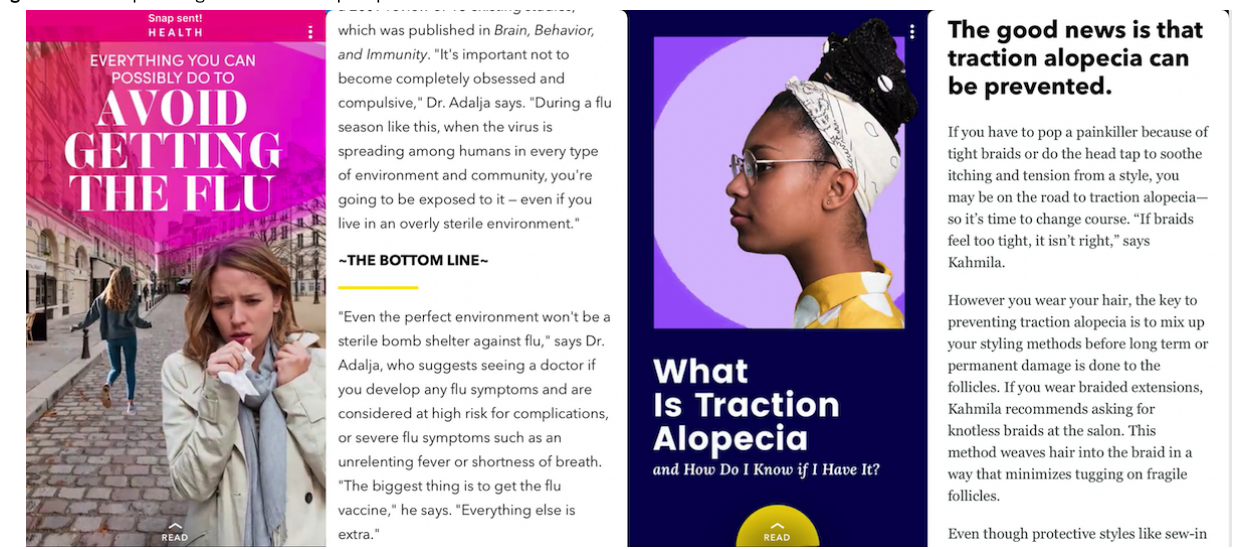
Figure 2. Examples of general health topics posted to female-focused Discover